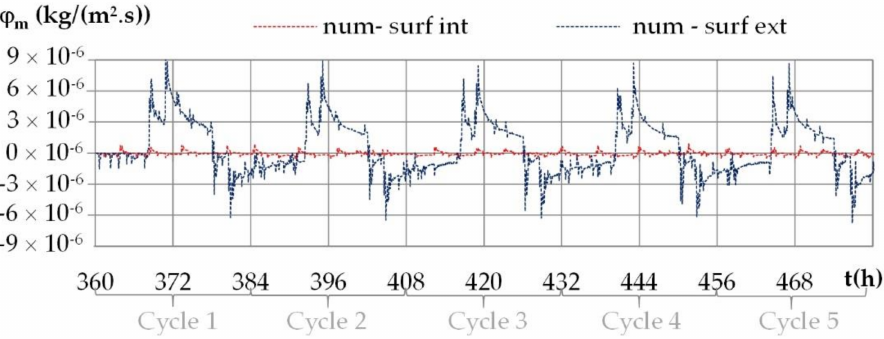
Figure 21. Numerical moisture fluxes on the interior and exterior surfaces during the daily cycles for the climate of Djerba.